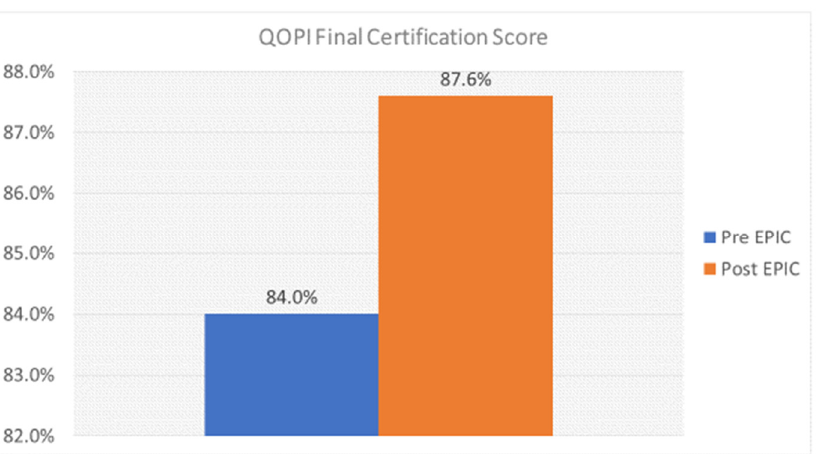
Figure 9. COH enterprise QOPI final certification scores. Blue represents the 3 reporting quarters (Fall 2016, Spring 2017 and Fall 2017) before the -EPIC implementation. Orange represents the 4 QOPI reporting quarters (Spring and Fall 2018 and Spring and Fall 2019) after the EPIC go live December